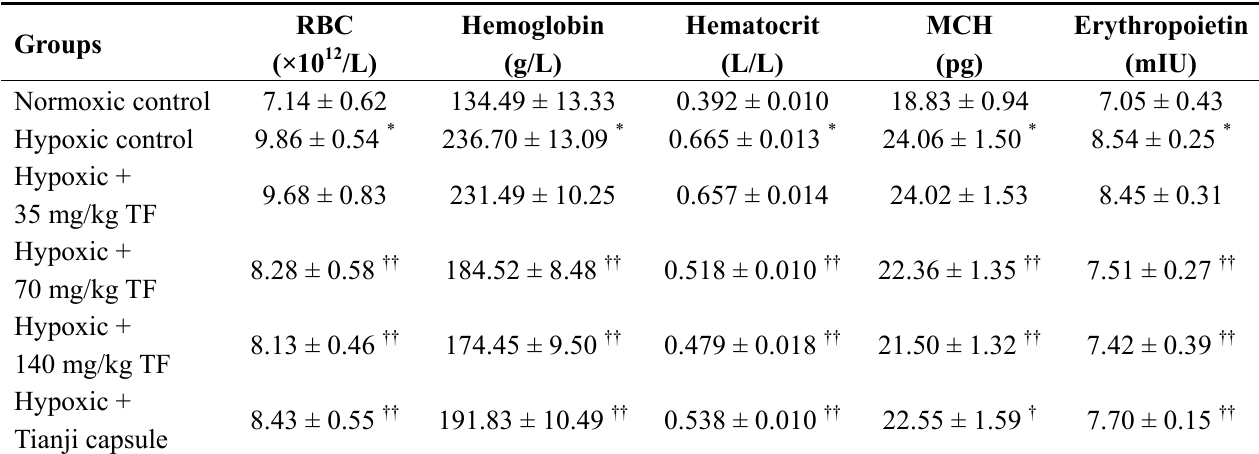
Table 1. Effect of total flavonoids of seabuckthorn on hematologic variables in high-altitude polycythemia